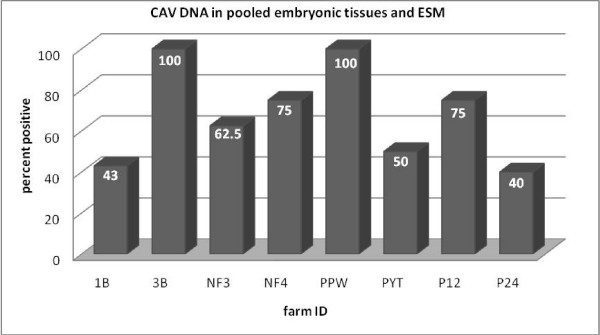
Detection of CAV DNA in pooled embryonic tissues and ESM from eggs collected from commercial broiler breeder farms. As it is shown on the graph, CAV DNA was detected in 40 to 100% of pooled embryonic tissue and ESM samples tested for different commercial broiler breeder farms.